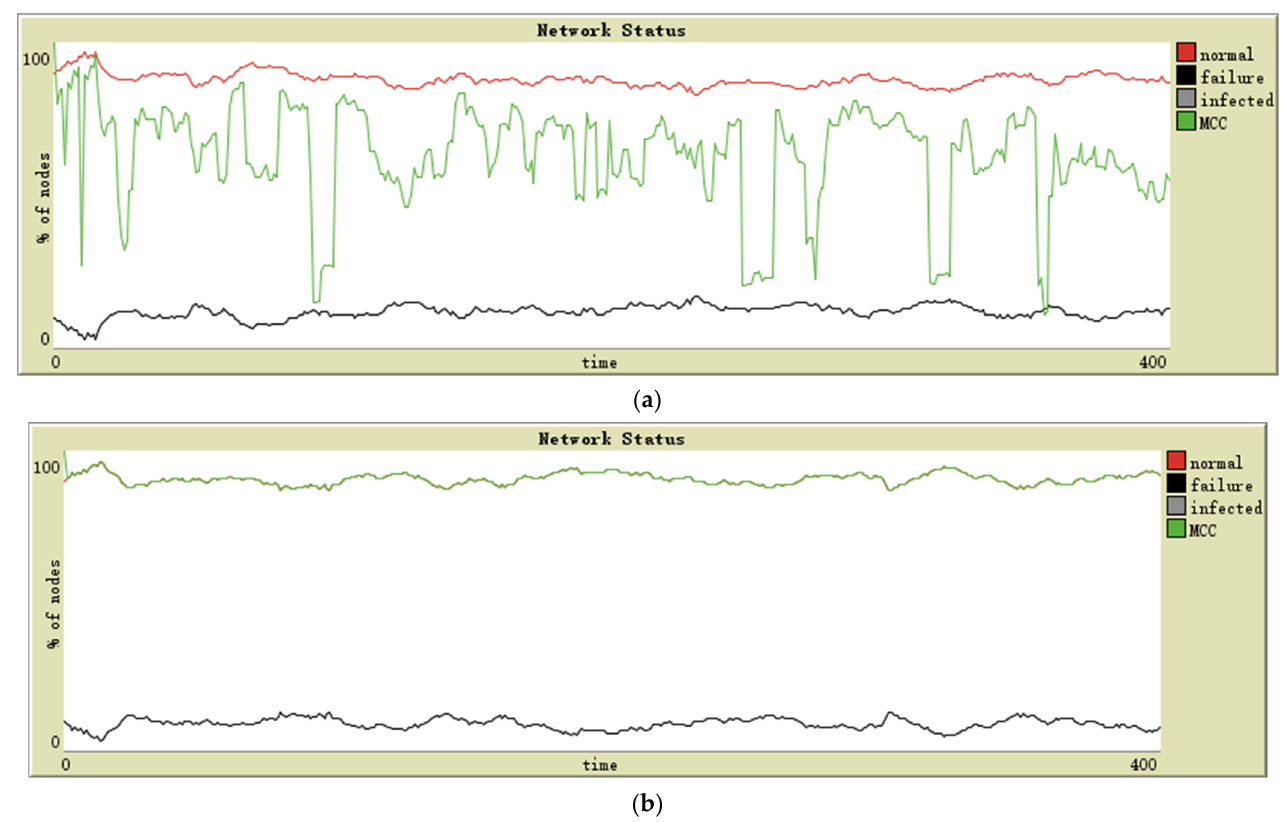
Figure 8. Simulation results of ( a ) scale-free network and ( b ) small-world network; malware propagation was not consid- ered.